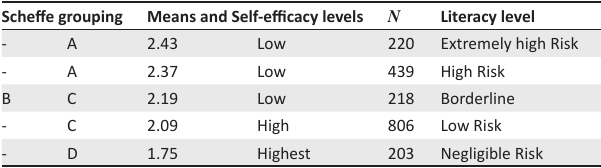
TABLE 3: Scheffe groupings and mean scores for literacy levels in relation to self-efficacy. Scheffe grouping Means and Self-efficacy levels